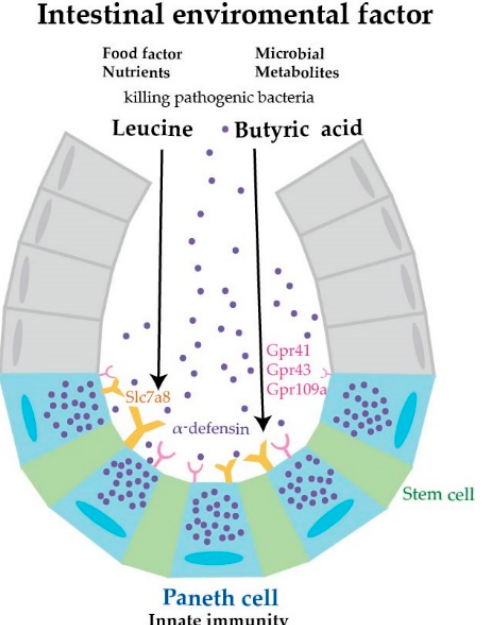
Figure 5. Paneth cell α -defensin secretion induced by nutrients in a possible regulation of intestinal homeostasis. This study indicates that the nutrients butyric acid and leucine induce α -defensin secretion from Paneth cells and further suggests that these nutrients perform previously unknown roles in regulating intestinal homeostasis.